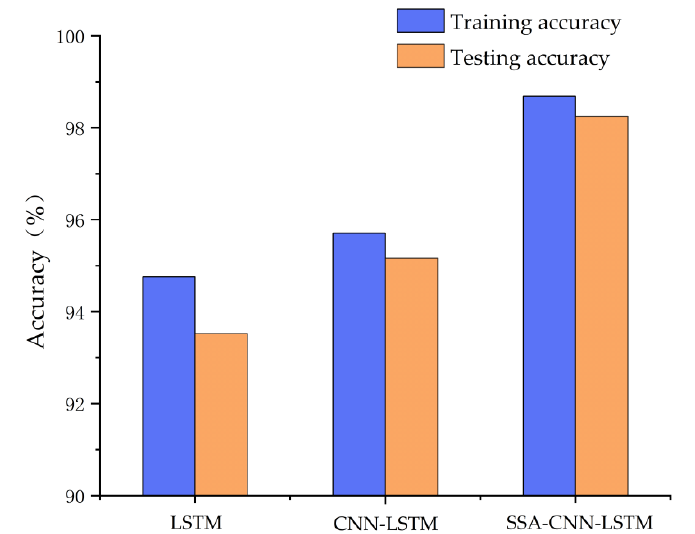
Figure 8. Loss value of the training dataset.